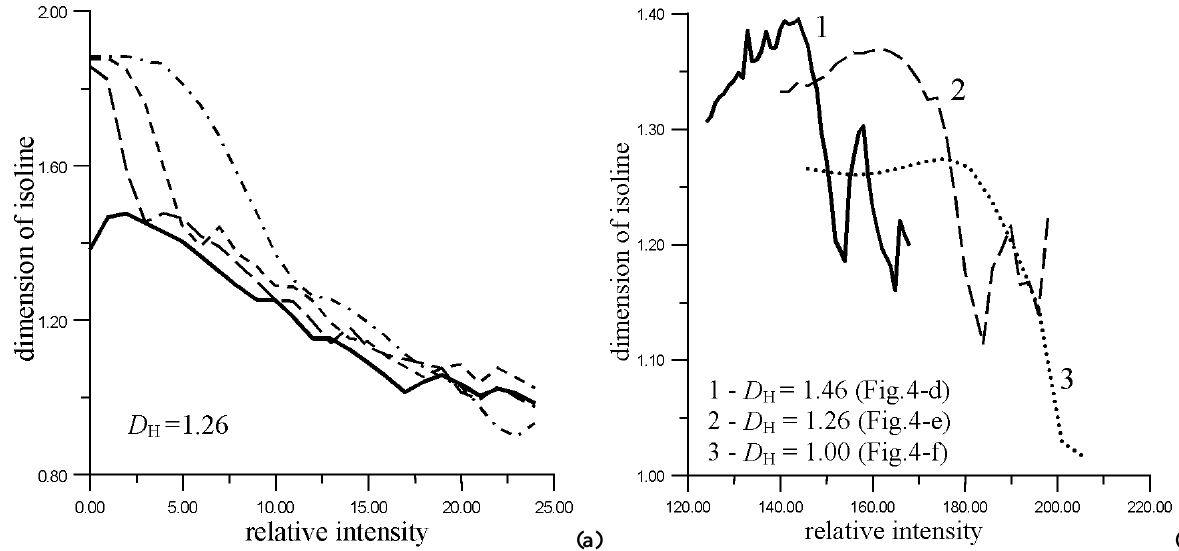
Fig. 7. Dependence of the isoline dimension spectrum on the noise: (a) linear sensitivity scale of model image, solid line – without noise, other lines – noise with zero mean and dispersions of 1, 4 and 9 units of intensity, respectively; (b) logarithmic sensitivity scale. D H – theoretical fractal dimension. References to Fig. 4 show the fractal structure used for image modelling.